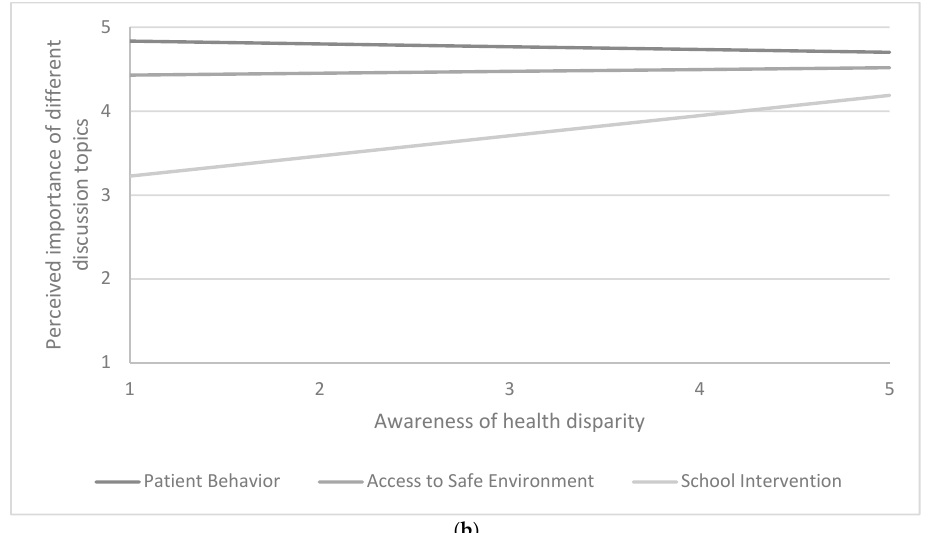
Figure 3. Estimated mean with 95% confidence interval for medical students’ perceived importance of ( a ) different roles, and ( b ) different topics that can be discussed with parents (scores ranging from 1 to 5, with a higher score indicating greater importance).